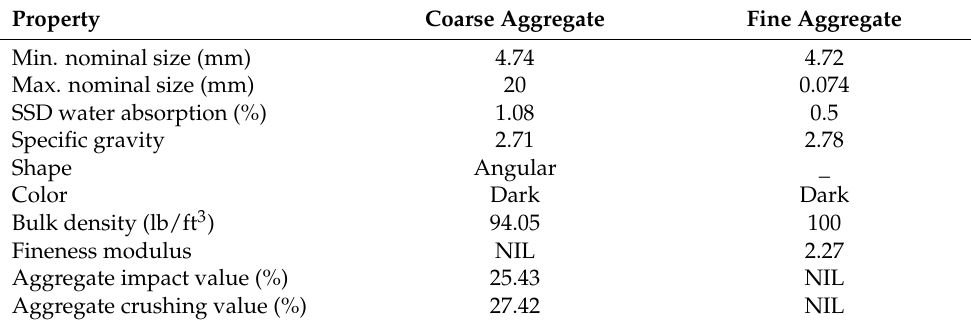
Table 2. Physical characteristics of